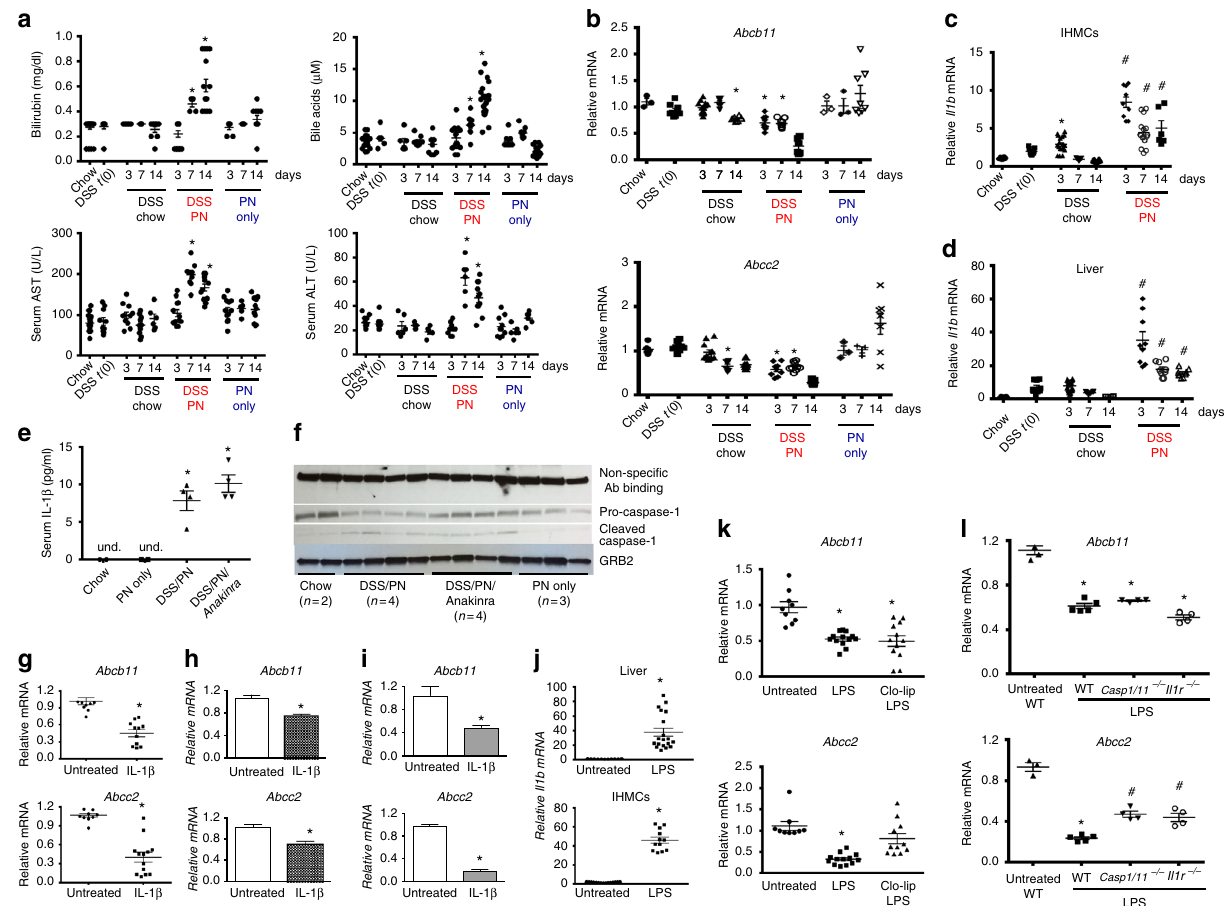
Fig. 2 IL-1 β precedes cholestasis and suppresses bile transporters. a Peripheral serum, AST, ALT, total bile acid, and bilirubin concentrations in chow mice, DSS mice immediately after completion of DSS pretreatment (DSS t (0) mice), DSS/chow, DSS/PN, and PN only mice for 3, 7, and 14 days. b Liver mRNA (same mice as in a ) of Abcb11 and Abcc2 and in puri fi ed intrahepatic mononuclear cells (IHMCs) ( c ) compared to liver homogenate ( d ) from chow, DSS t (0), DSS/chow, and DSS/PN mice. e Peripheral serum IL-1 β concentrations. f Immunoblot on liver homogenate for procaspase-1 and cleaved caspase-1; protein bands due to non-speci fi c binding of this antibody and for anti-GRB2 antibody were used to show equal protein loading. For the latter, the blot needed to be stripped due to proximity in size of GRB2 (25 kDa) and IL-1 β (17 kDa active, 31 kDa pro-form). g Liver mRNA of Abcb11 and Abcc2 from untreated and IL-1 β -injected mice after 4 h in Abcb11 mRNA and Abcc2 mRNA in HuH7 cells ( h ) or primary mouse hepatocytes ( i ) left untreated or exposed to IL-1 β (10 ng/ml) for 4 h. For h and i representative data are shown depicting mean ± SEM of technical triplicates from one out of at least fi ve experiments. j , k Il1b , Abcb11 , and Abcc2 mRNA expression in liver homogenate or in IHMCs from untreated and LPS injected mice after 4 h with or without prior (16 h) i.p. clodronate-liposome (Clo-lip) injection and in WT, Casp1/11 − / − , or Il1r − / − mice ( l ). * p < 0.05 vs. all other groups by one-way ANOVA and Tukey's correction ( a , b , e ). * p < 0.05 vs. chow, and # p < 0.05 vs. chow/DSS and chow ( c , d ). * p < 0/05 vs. untreated by t test ( g , h , i , j ); * p < 0.05 vs. untreated and LPS-Clo-lip one-way ANOVA and Tukey's correction ( k ); * p < 0.05 vs. untreated, and # p < 0.05 vs. WT by one-way ANOVA and Tukey's correction ( l ). Data are depicted as individual mice for serum analysis and as means from PCR triplicates from individual mice for gene expression data (mean ±